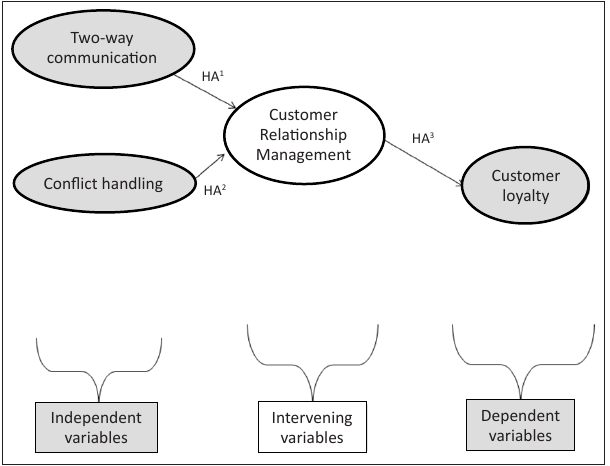
FIGURE 1: Conceptual